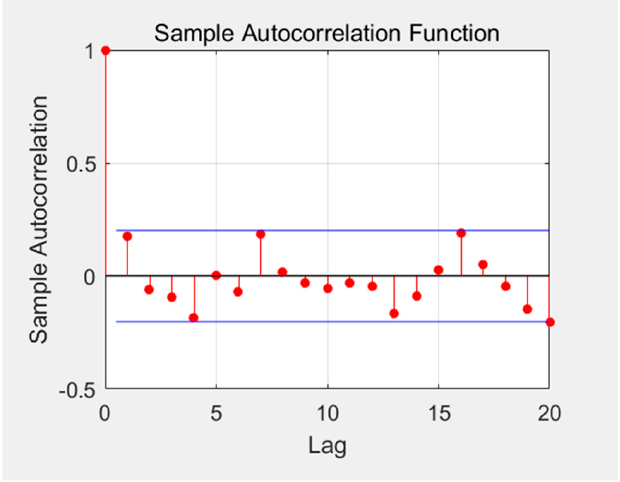
Figure 11. ACF function diagram.